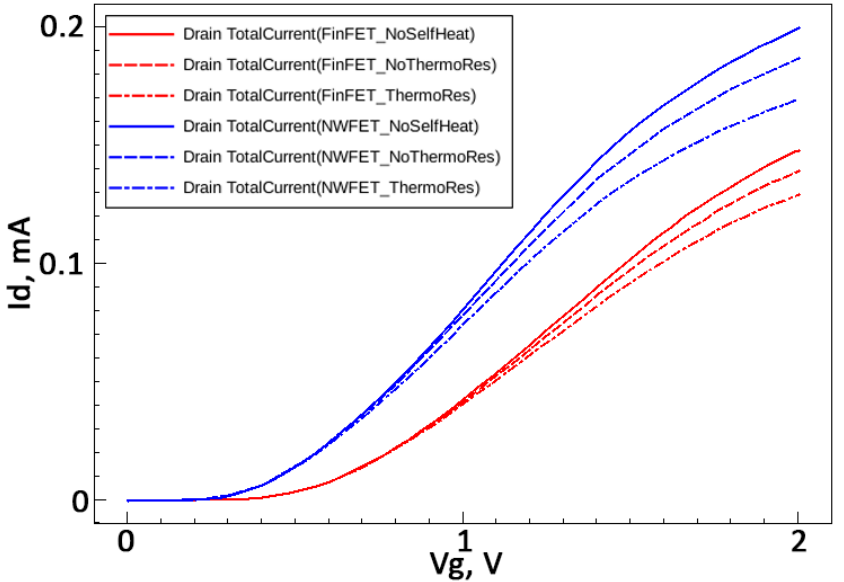
Figure 12. Comparison of FinFET and NWFET I d -V g characteristics taking into account